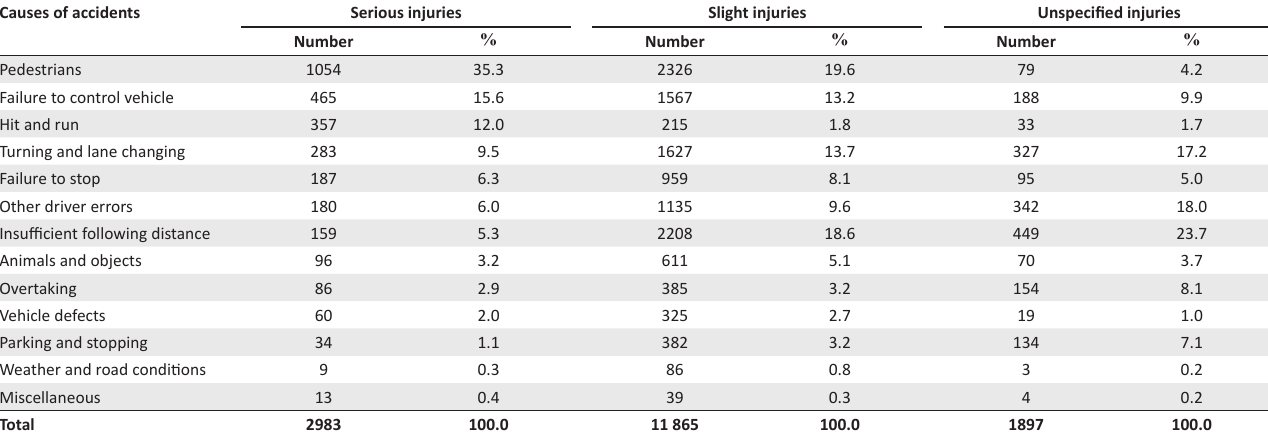
TABLE 4: Leading causes of road crashes in the City of Cape Town